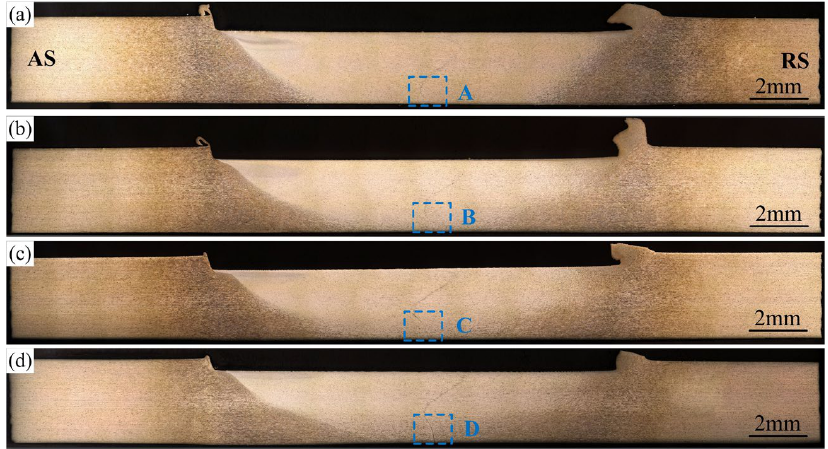
Figure 11. Weld transverse cross-sections to various welding speeds: ( a ) v = 30 mm/min; ( b ) v = 50 mm/min; ( c ) v = 80 mm/min; ( d ) v = 100 mm/min; ( ω = 900 rpm, d = 12